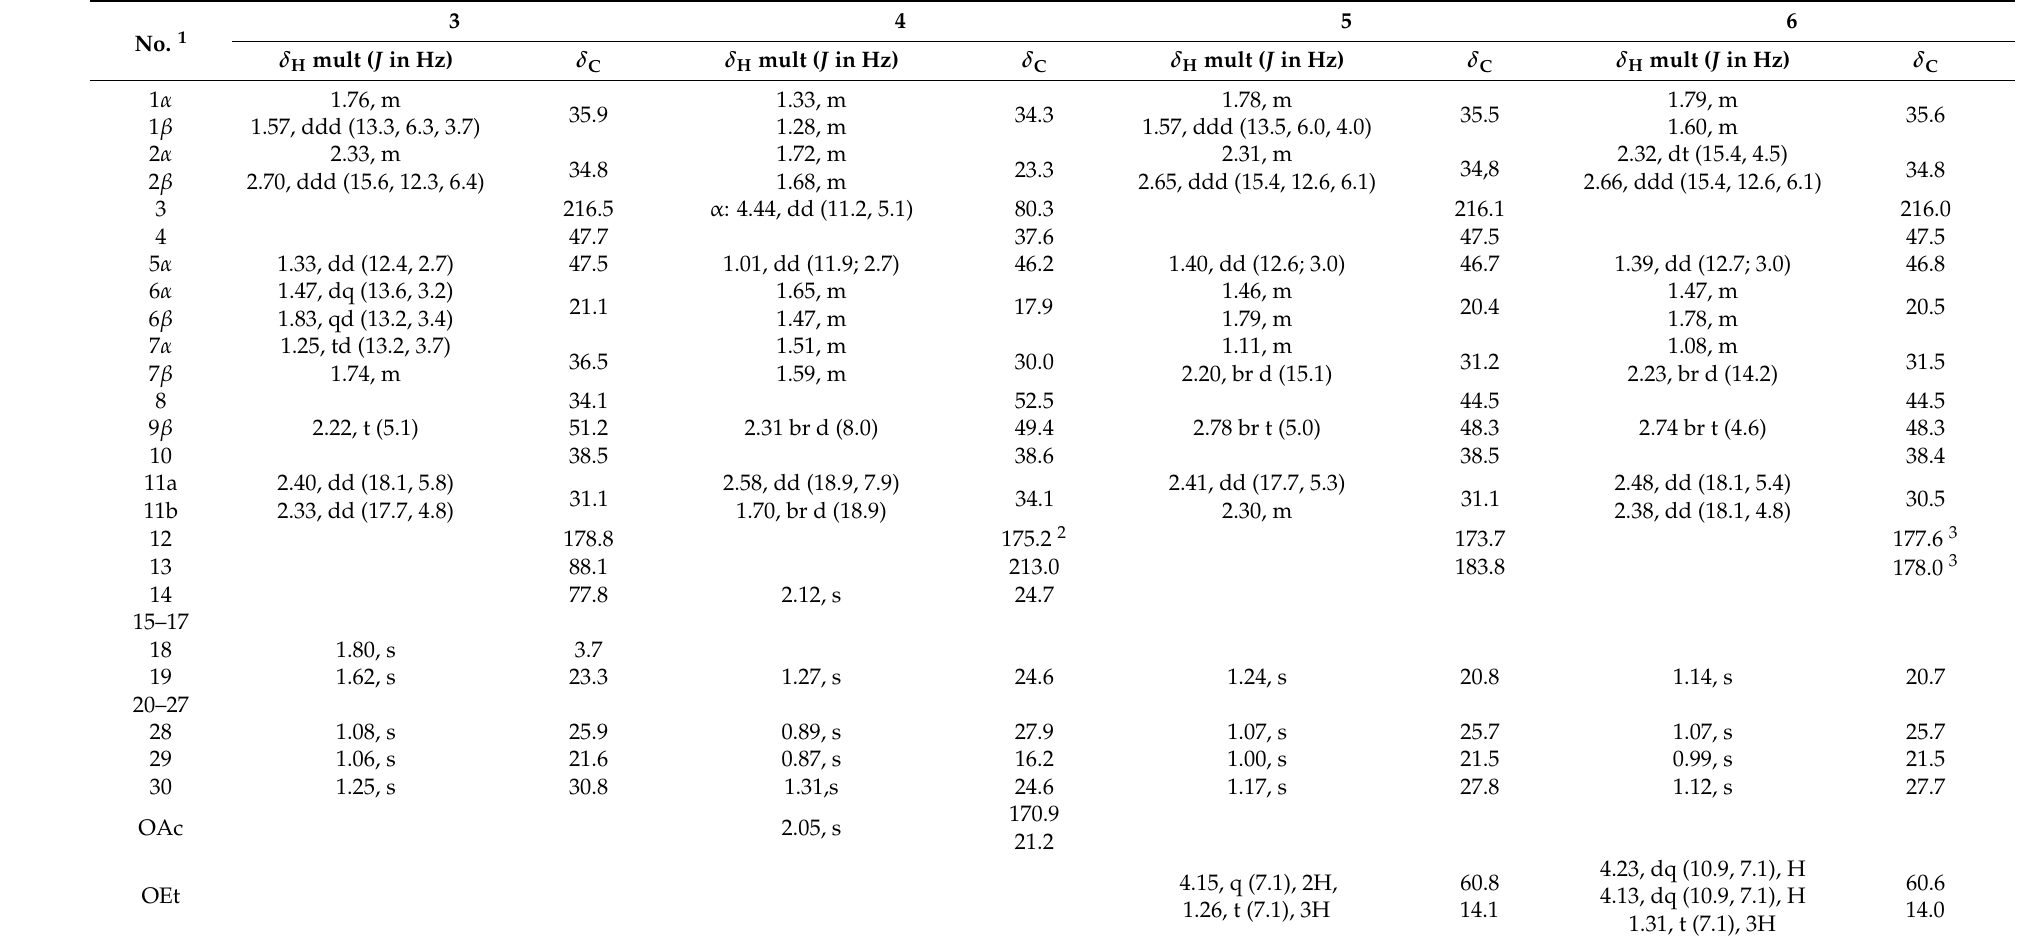
Table 2. 1 H and 13 C NMR data (700 and 176 MHz) of 3 – 6 in CDCl 3